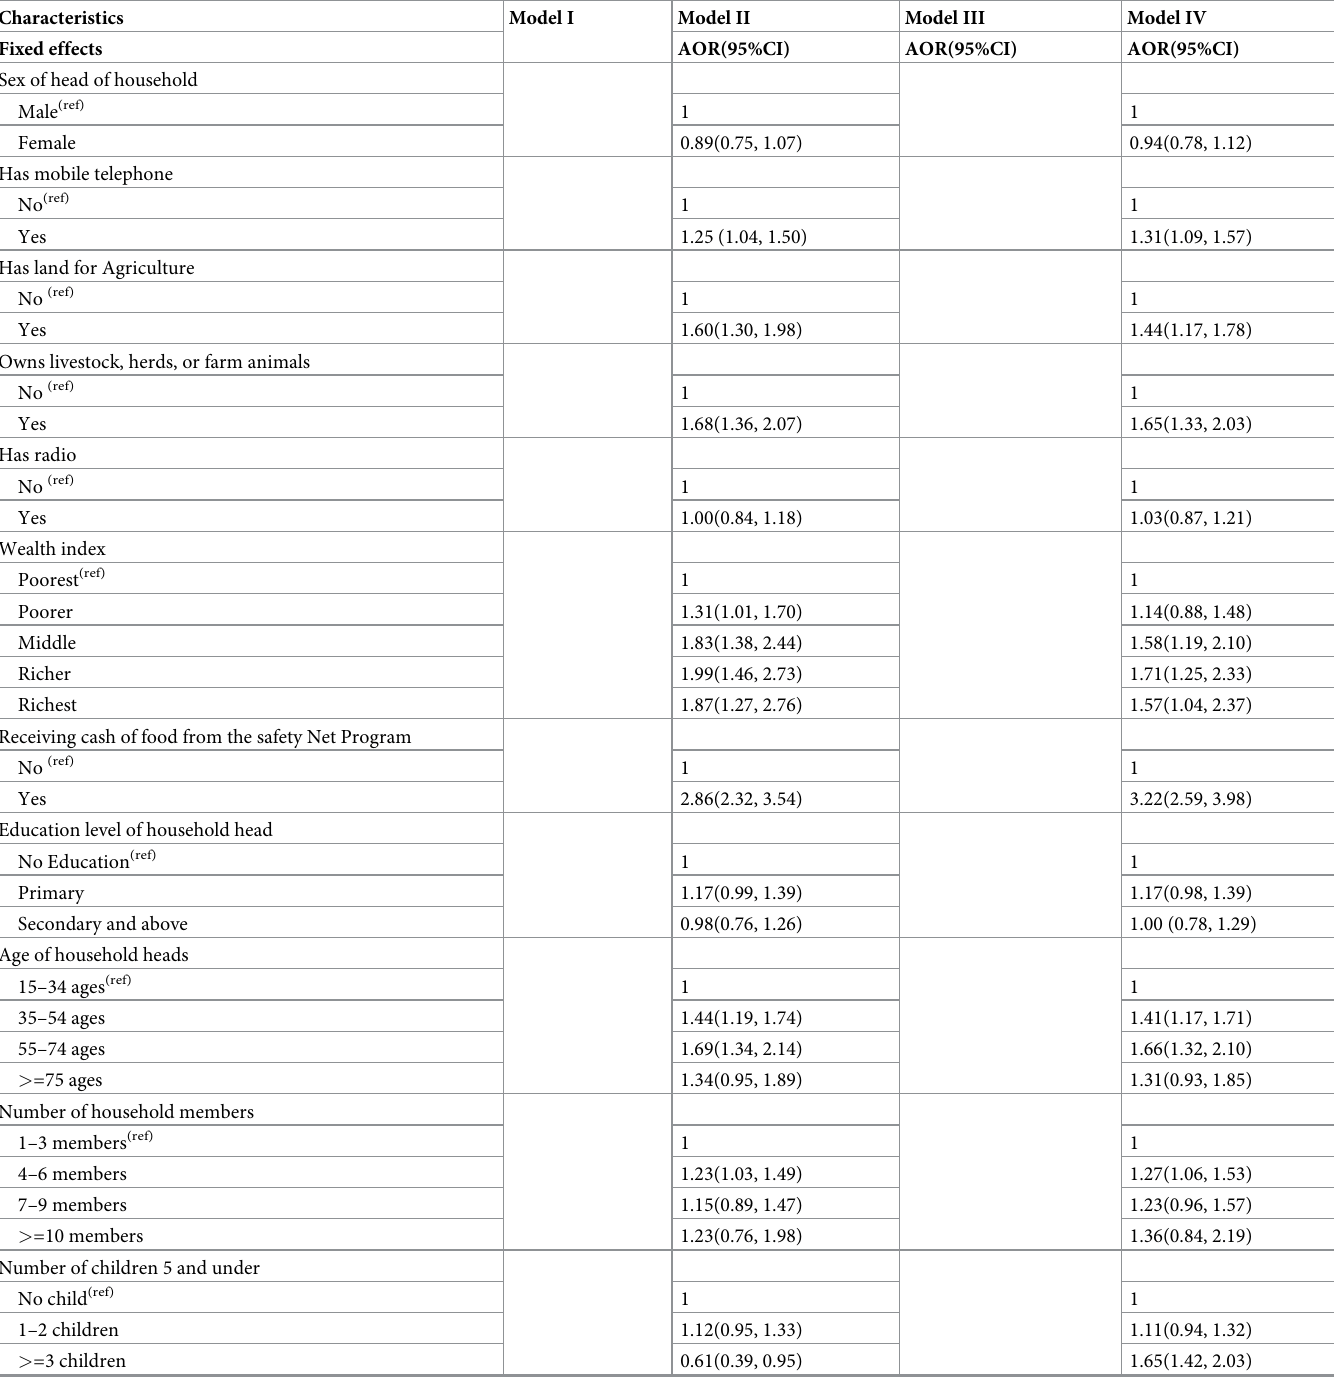
Table 3. Multilevel logistic regression analysis of individual and community-level factors associated with CBHI enrollment in Ethiopia.